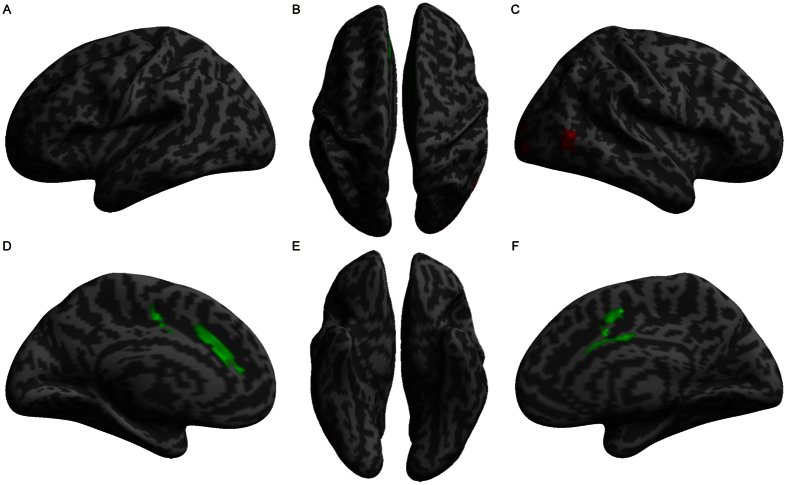
Correlations between hearing damage duration and gray matter volume.The red color indicates voxels with positive relationships, and the green color indicates voxels with negative relationships.